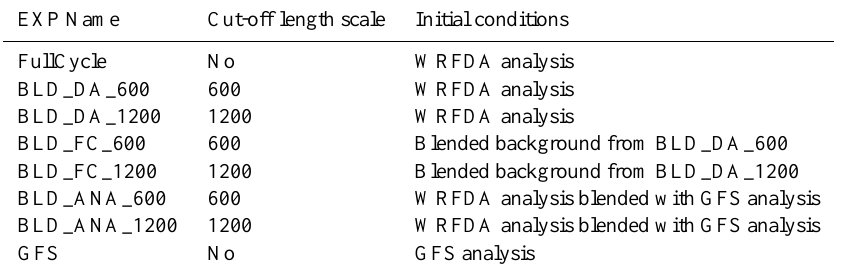
Table 1. Experiment descriptions.